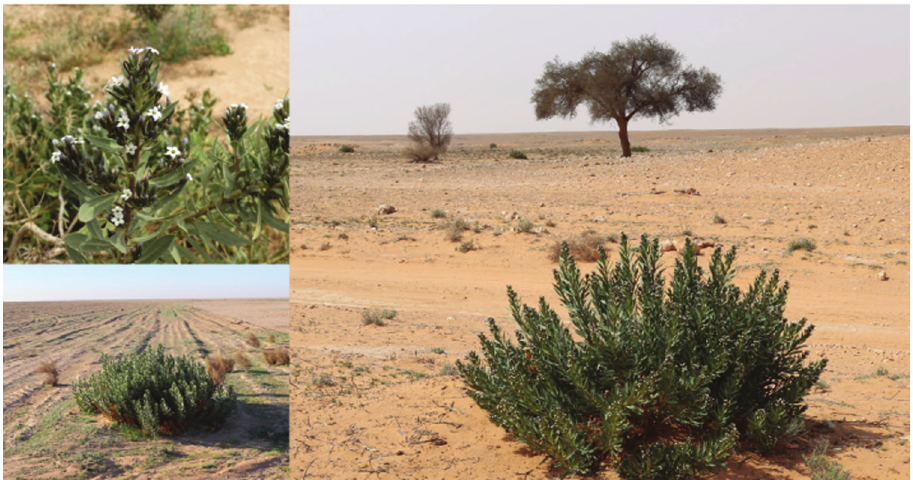
Figure 3. Rhazya stricta at Birkat Al-Talhat, Al-Najaf desert, Iraq. Photograph by Mohmmad K. Mohammad.